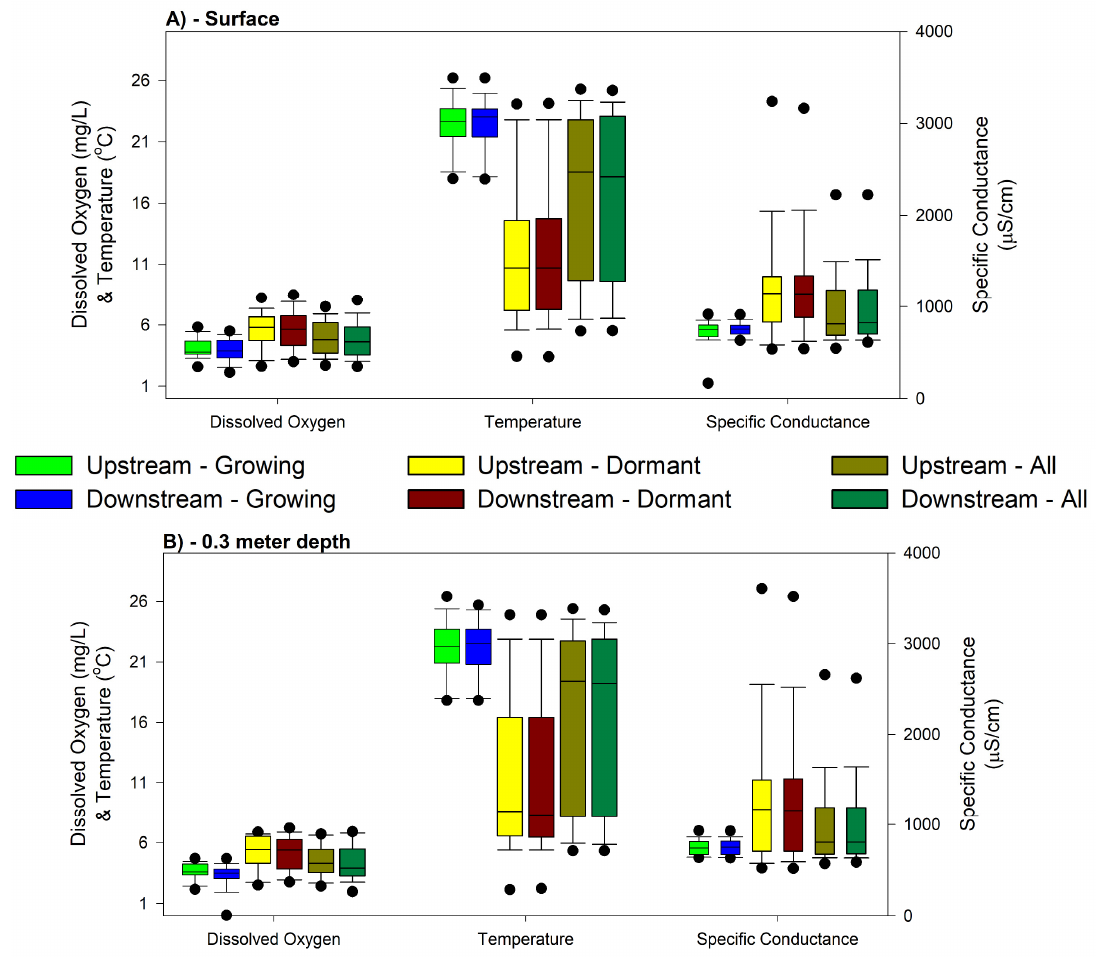
Figure 4. Measured in-situ parameters in the waters upstream and downstream of the AFW presented by season (growing or dormant) and collectively (all) for ( A ) surface waters and ( B ) waters at a 0.3 m depth.